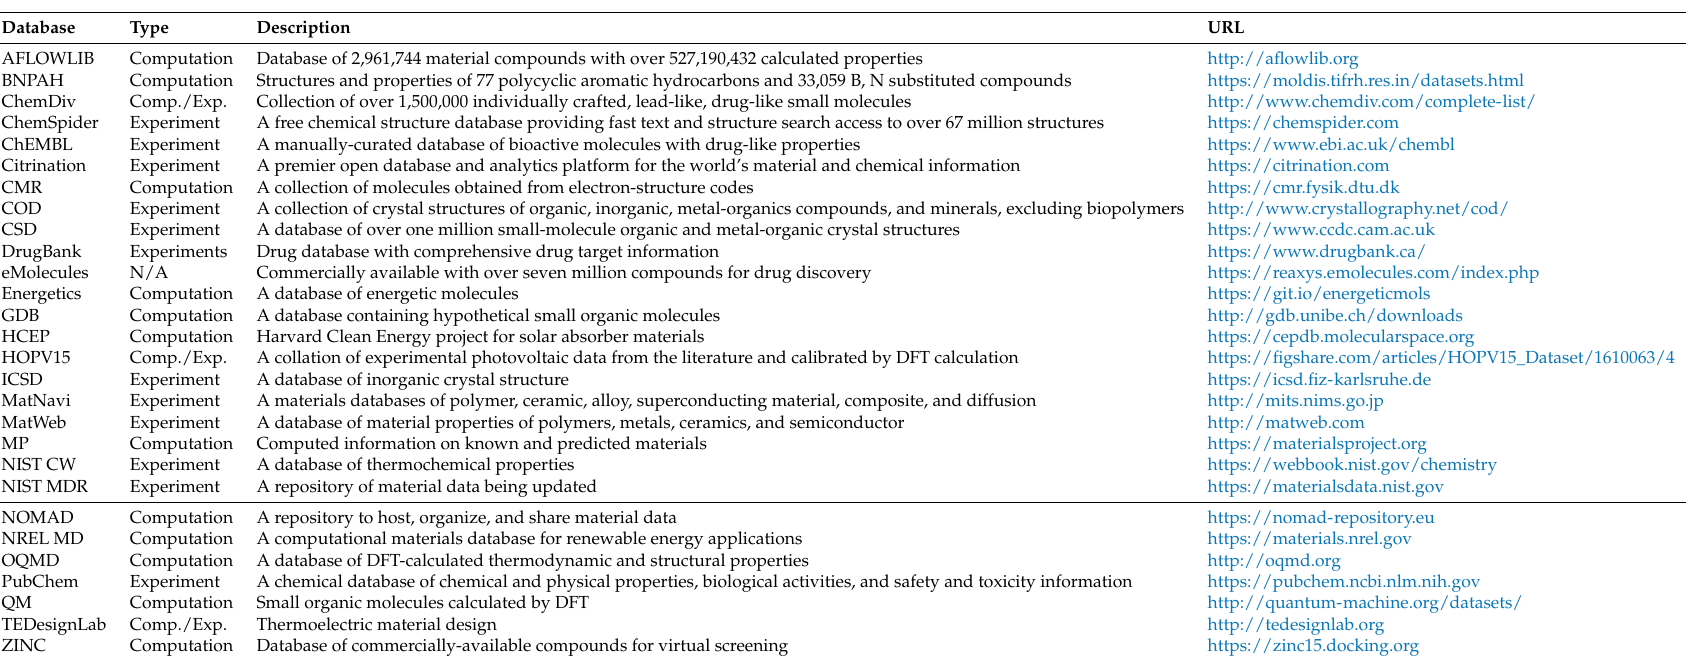
Table 2. Some public materials databases enclosing structures and